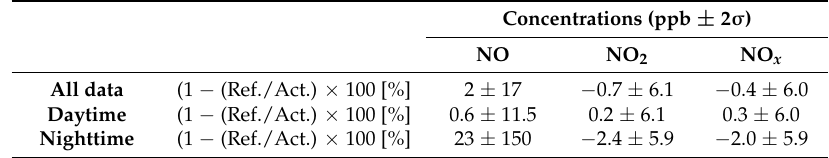
Table 12. Average concentrations of NO, NO 2 , and NO x in both canyons for daytime (06:00–20:30) and nighttime (20:30–06:00) and relative concentration differences; negative values imply a photocatalytic effect in the active canyon